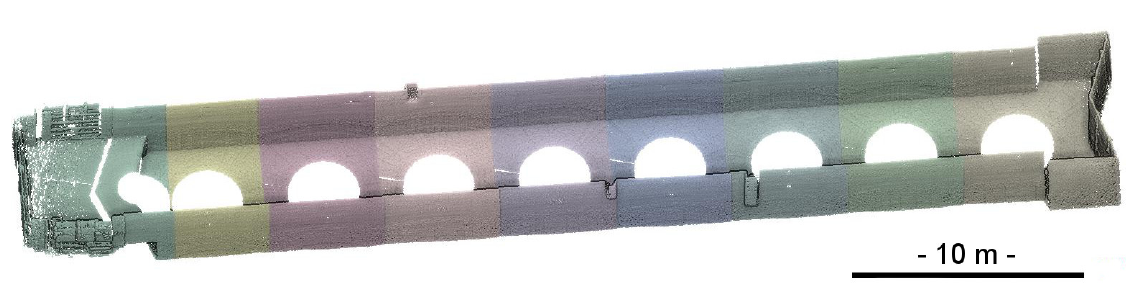
Figure 8. Global MSS model of the lock chamber. The scans are shown in different colours.